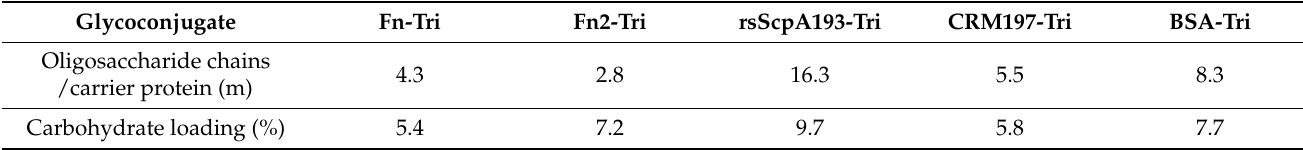
Figure 7. MALDI-TOF MS and SDS-PAGE results for ( A ) Fn and Fn-trisaccharide conjugate (Fn-Tri), ( B ) Fn2 and Fn2- trisaccharide conjugate (Fn2-Tri), ( C ) rsScpA193 and rsScpA193-trisaccharide conjugate (rsScpA-Tri), ( D ) CRM197 and CRM197-trisaccharide conjugate (CRM197-Tri) and ( E ) BSA and BSA-trisaccharide (BSA-Tri) conjugate. Table 1. Carbohydrate Loading of